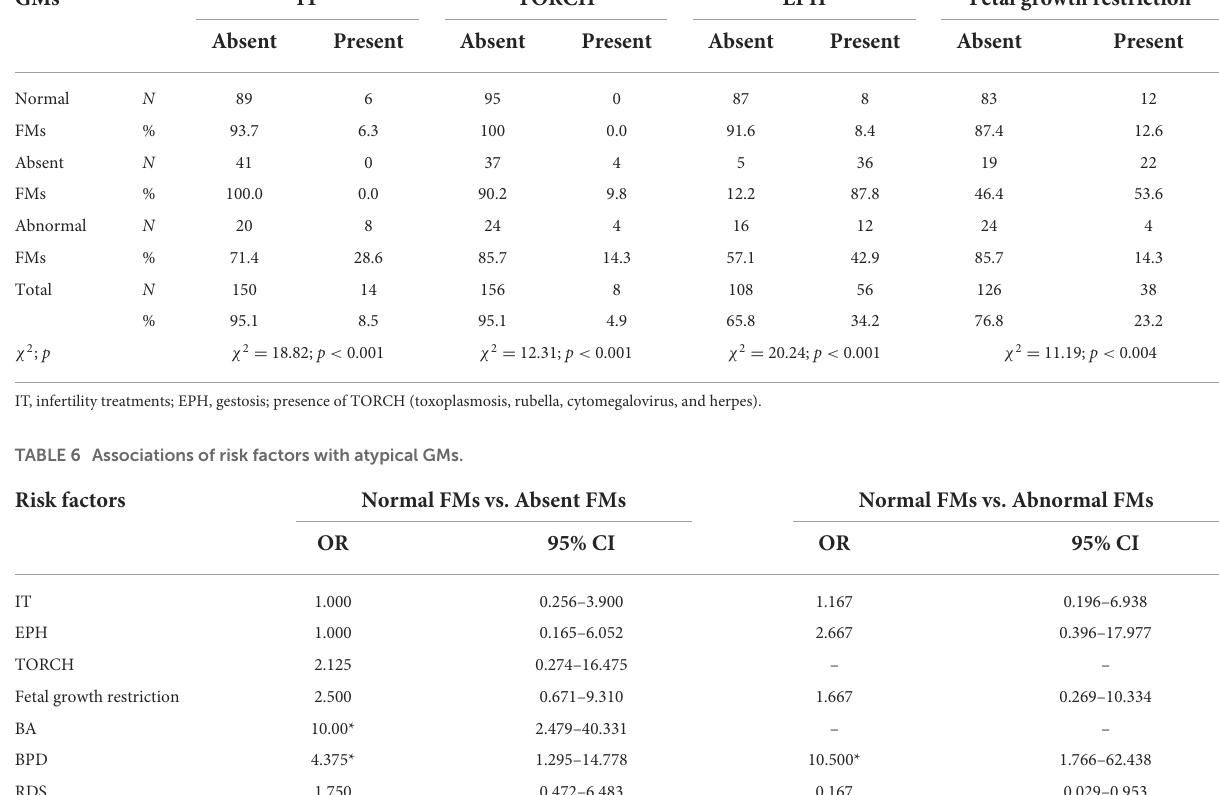
TABLE 5 Chi-squared distribution table for the association between prenatal risk factors and a particular GM pattern. GMs IT TORCH EPH Fetal growth restriction Absent Present Absent Present Absent Present Absent Present